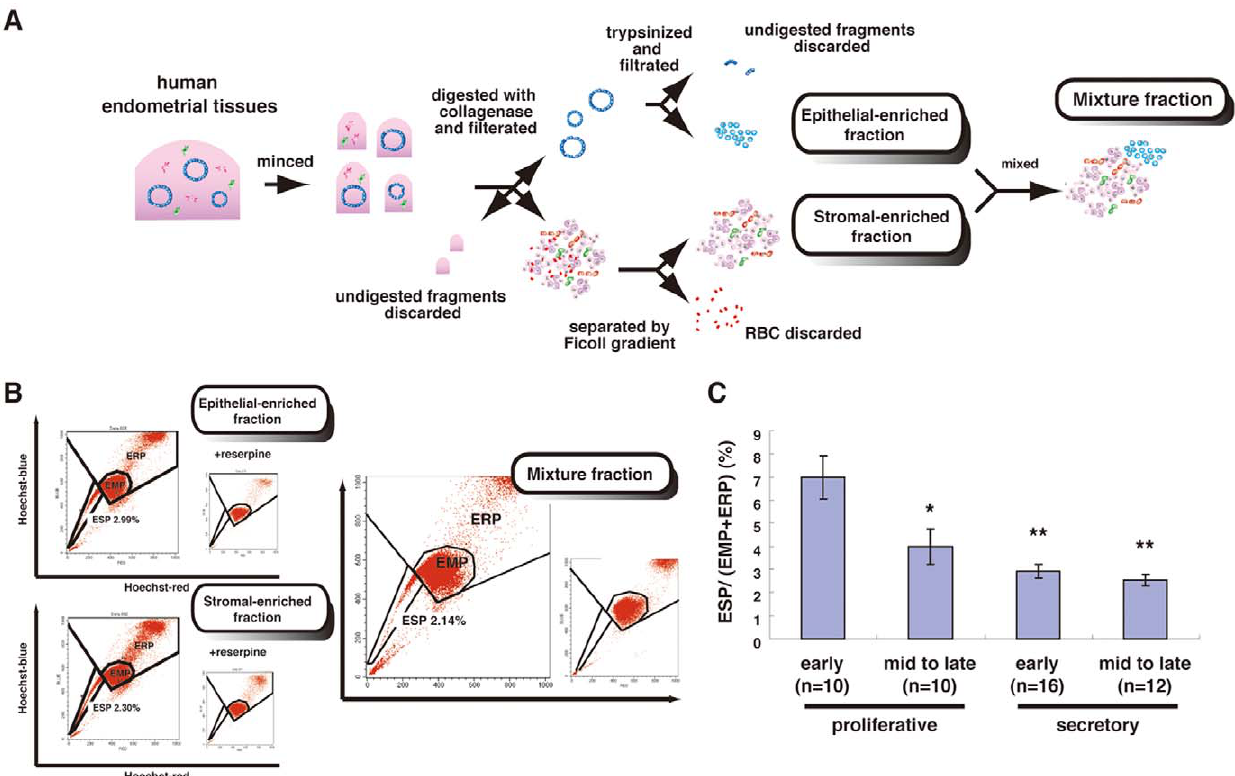
Figure 1. Isolation of ESP and EMP cells. ( A ) Summary of procedures for the preparation of epithelial-enriched and stromal-enriched fractions and the mixture of both fractions from human cycling endometria. ( B ) Flow cytometric distribution of ESP cells, EMP cells, and the endometrial replicative population (ERP) in each of the three fractions stained with Hoechst 33342 indicated in Figure S1. Addition of 50 m M reserpine resulted in the disappearance of the ESP fraction (inset in each panel). ( C ) Proportion of ESP in the whole fraction dissociated from human endometria at different phases of the menstrual cycle. * P , 0.01 and ** P , 0.00005, versus early proliferative phase. Each bar indicates the mean 6 SEM. n=48.